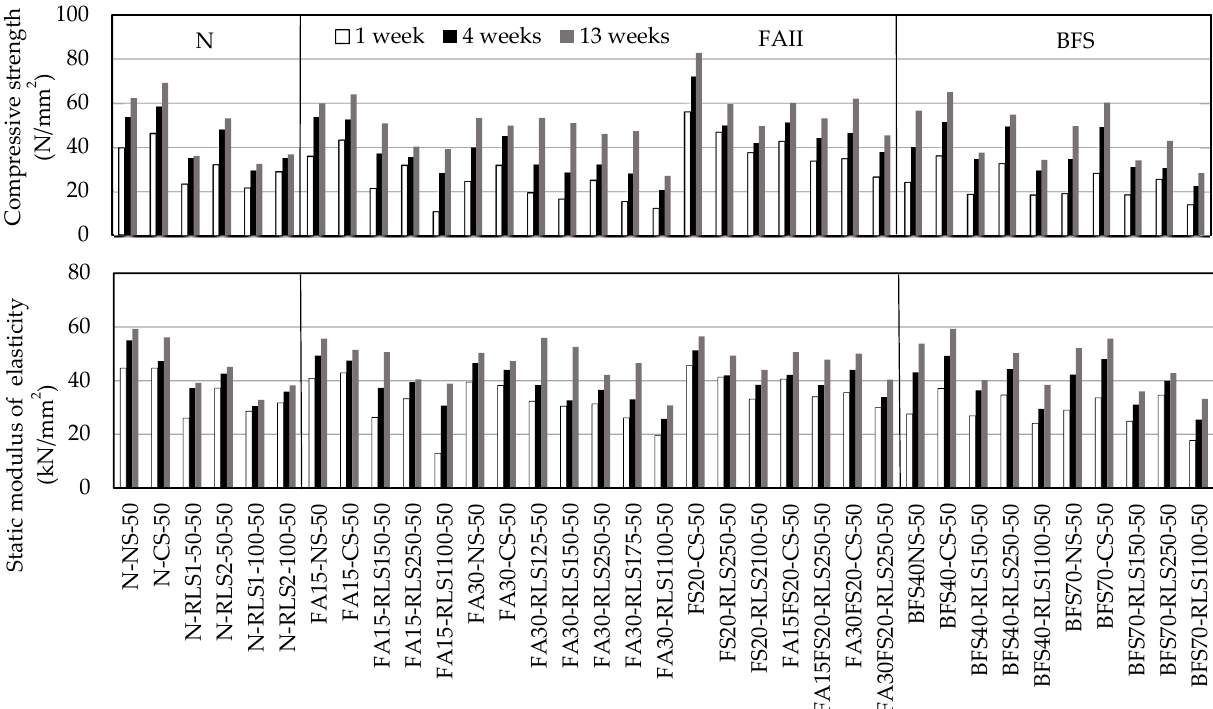
Figure 2. Compressive strength and static modulus of elasticity of mortar.